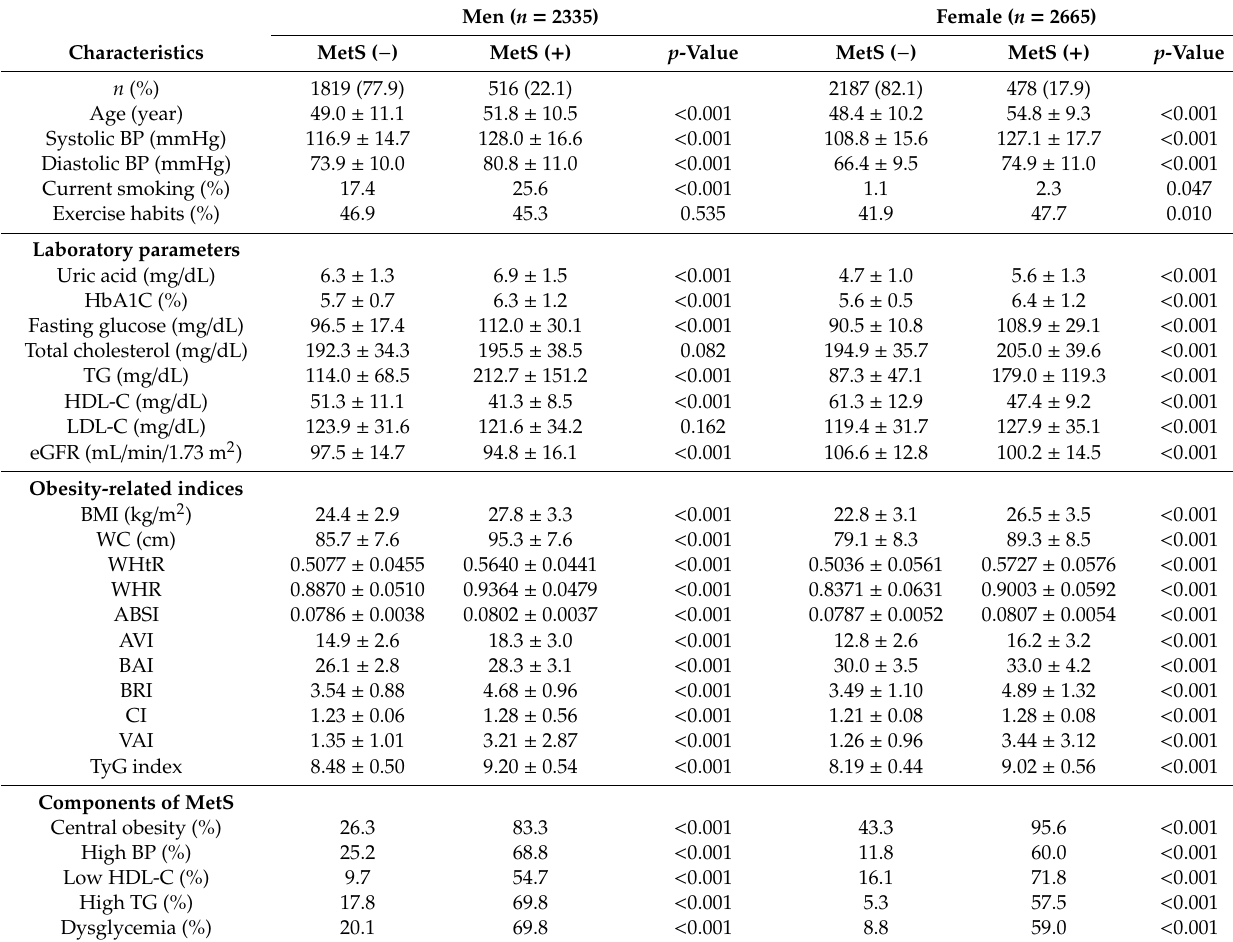
Table 1. Clinical characteristics of the study participants classified by the presence of